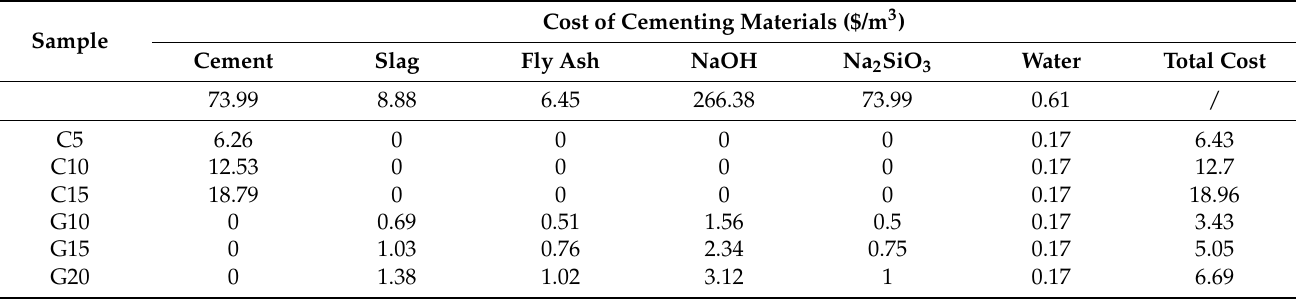
Table 6. Cost of cementing materials per cubic meter of stabilized aeolian sand.